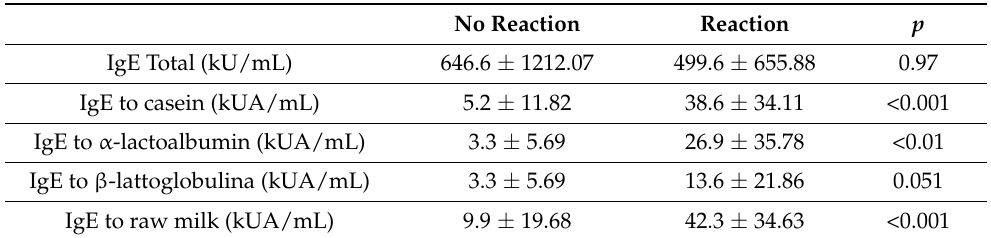
Table 3. Comparison of the laboratory between patients without reactions and with reactions during